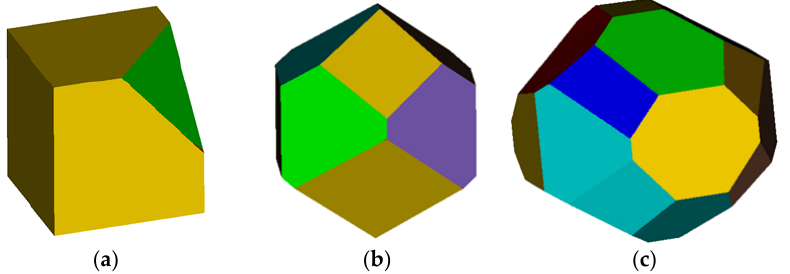
Figure 14. Cutting effect in Vericut platform. ( a ) 1st cutting; ( b ) 8th cutting; ( c ) 19th cutting.